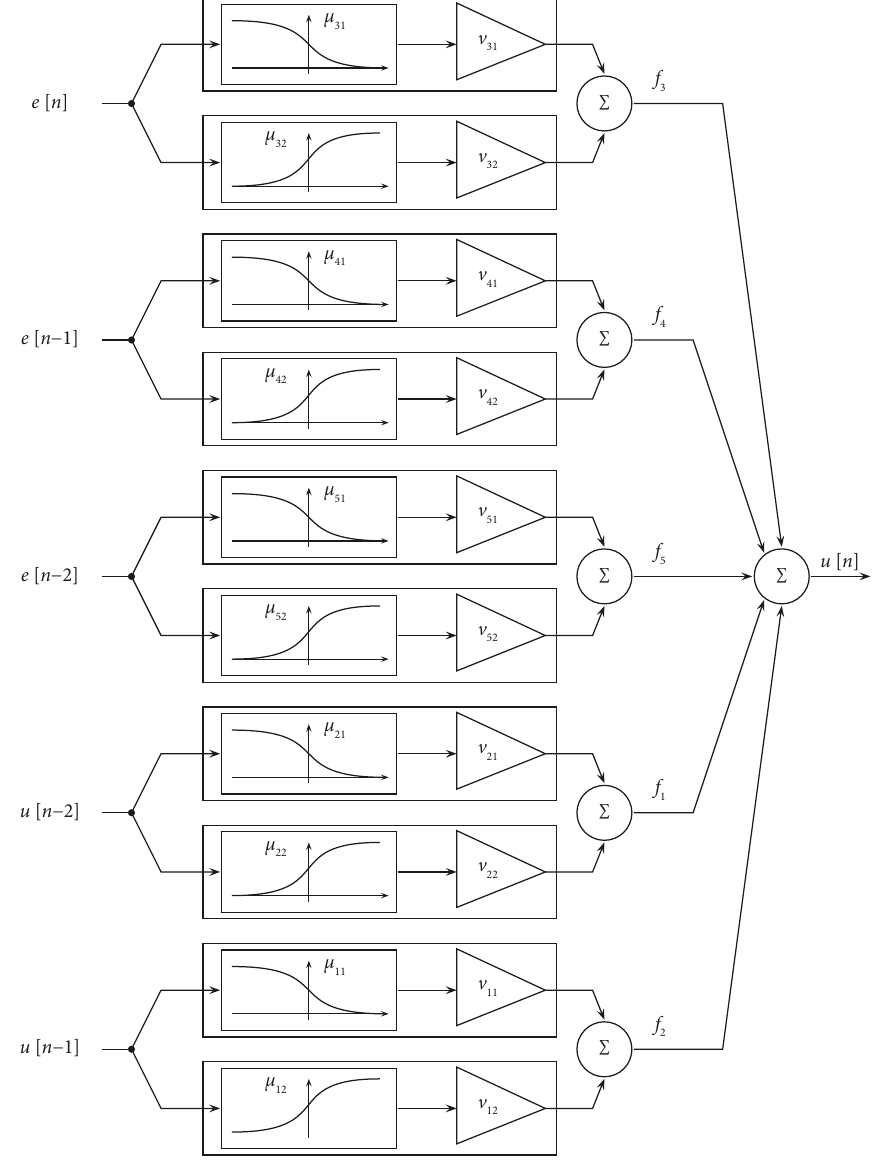
Figure 9: Scheme of the neuro-fuzzy control